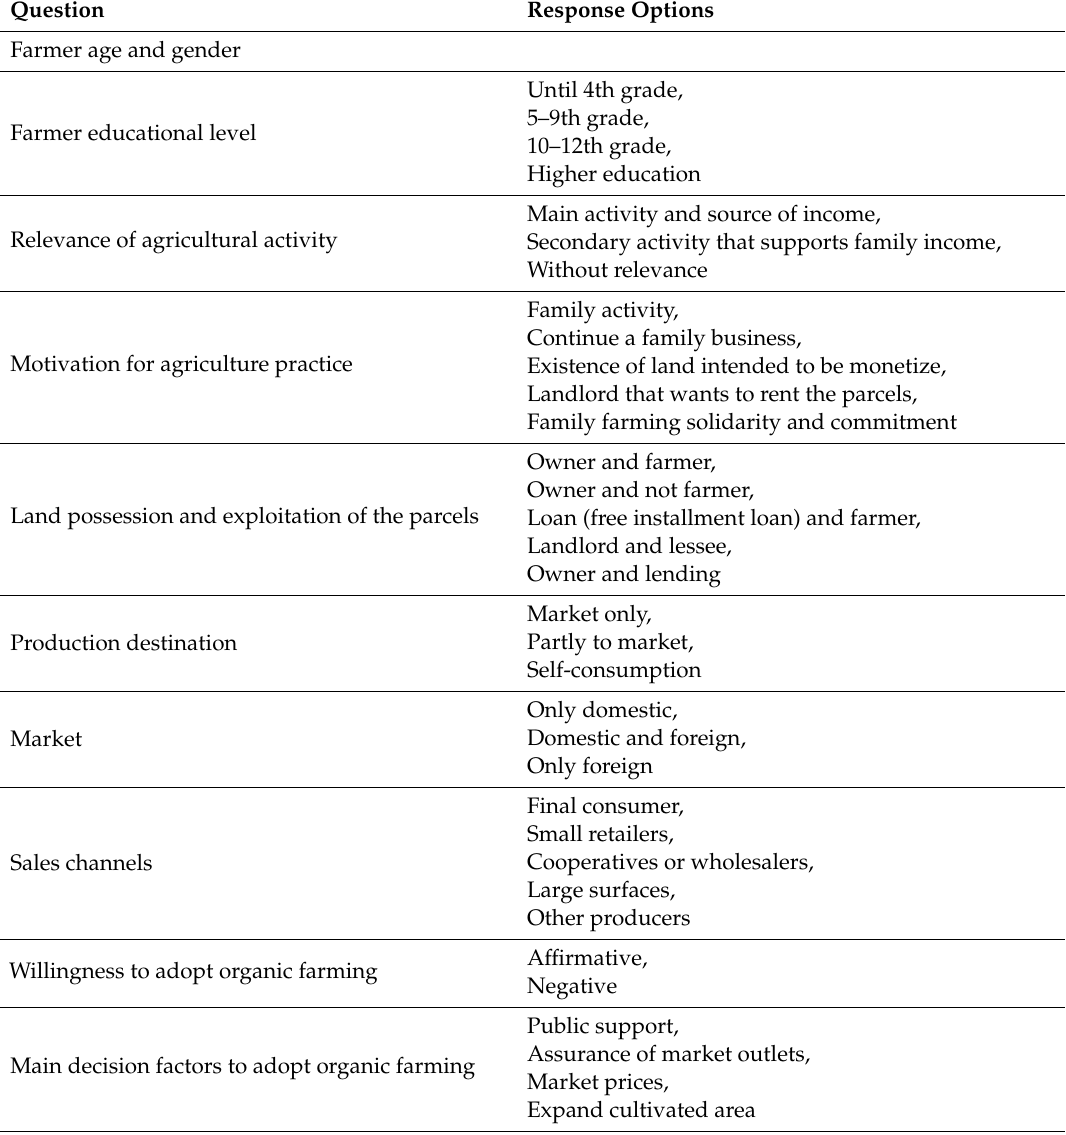
Table A1. Farmers